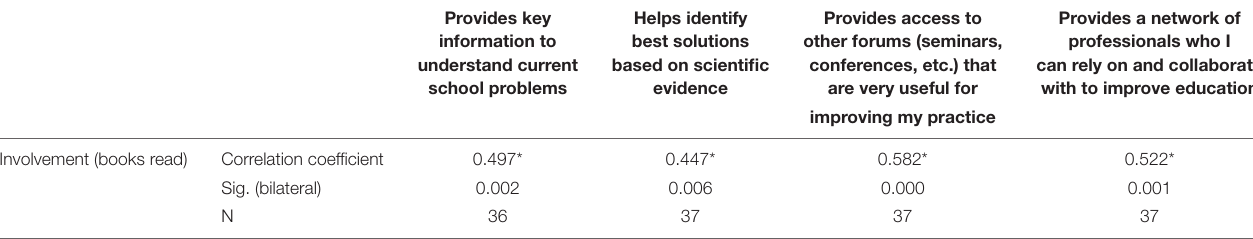
TABLE 1 | Spearman’s bivariate analysis of involvement in the seminar and use of scientific literature. Provides key Helps identify Provides access